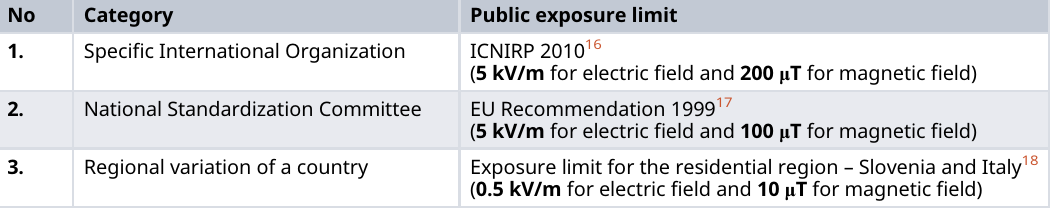
Table 4. Benchmarked public exposure limits.